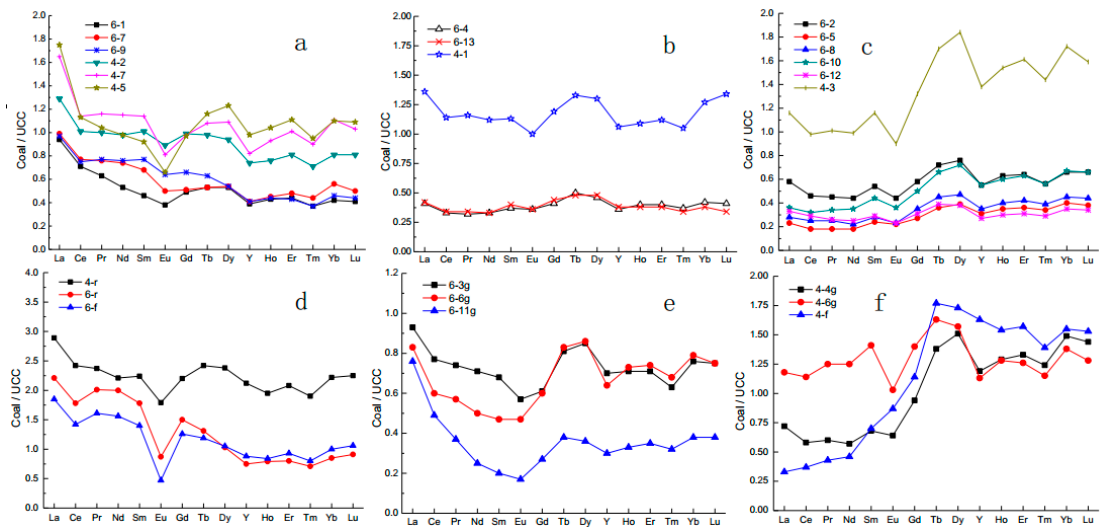
Figure 8. Rare earth and yttrium (REY) distribution patterns in the coal benches and the roof, floor, and parting strata of coal beds. REY plots were normalized by Upper Continental Crust (UCC) [48]. For coal bench samples: ( a ) L-type; ( b ) M-type; ( c ) H-type; For roof, floor and parting samples; ( d ) L-type; ( e ) M-type; ( f ) H-type.